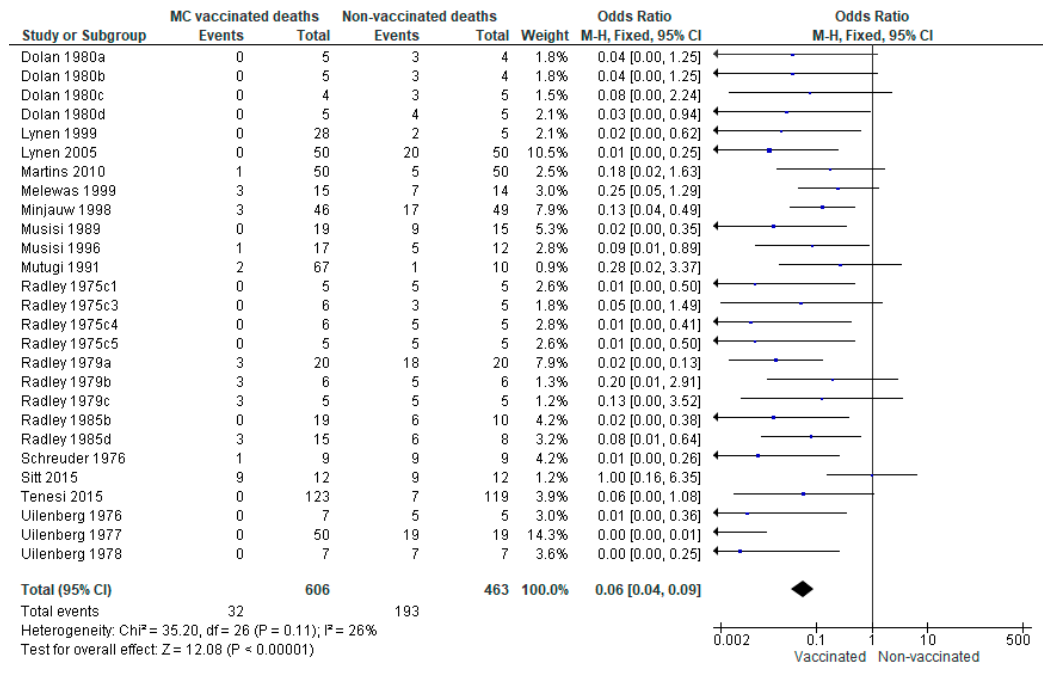
Figure 2. Forest plot showing comparison of mortality in Muguga cocktail (MC) vaccinated vs. nonvaccinated. The blue boxes represent the effect size (odds ratio) of each study—a bigger box indicates the study was weighted more, i.e., a larger sample size. The black diamond represents the pooled OR of the studies.